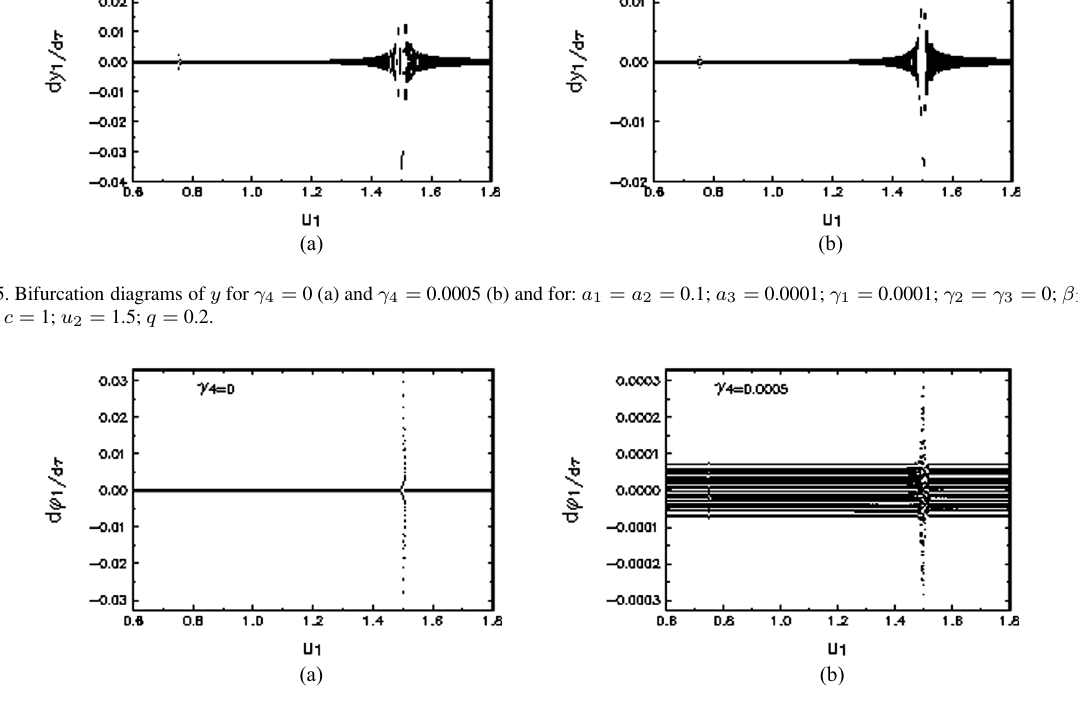
Fig. 6. Bifurcation diagrams of ϕ 1 for γ 4 = 0 (a) and γ 4 = 0.0005 (b) and for: a 1 = a 2 = 0.1; a 3 = 0.0001; γ 1 = 0.0001; γ 2 = γ 3 = 0; β